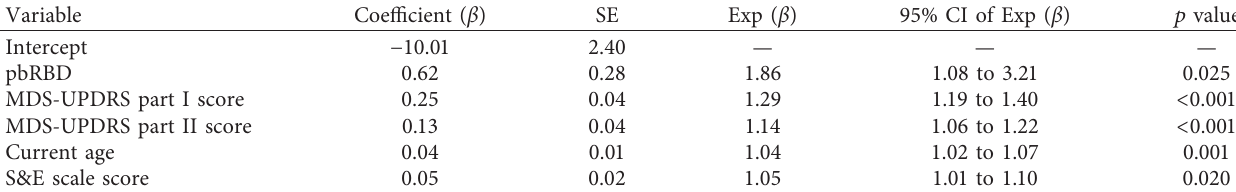
Table 3: Regression model predicting a SCOPA-AUT score of ≥ 10 in patients with early PD.